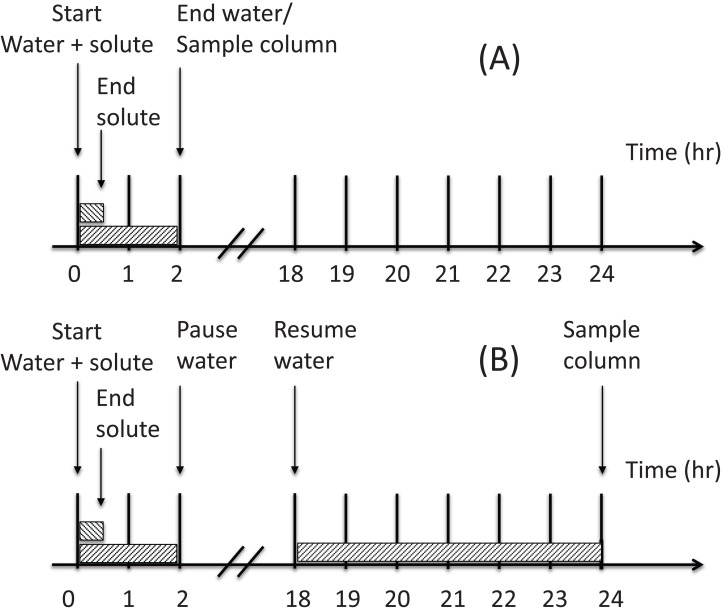
Schematic of the two irrigation scenarios (A) and (B) applied to the wedge columns.